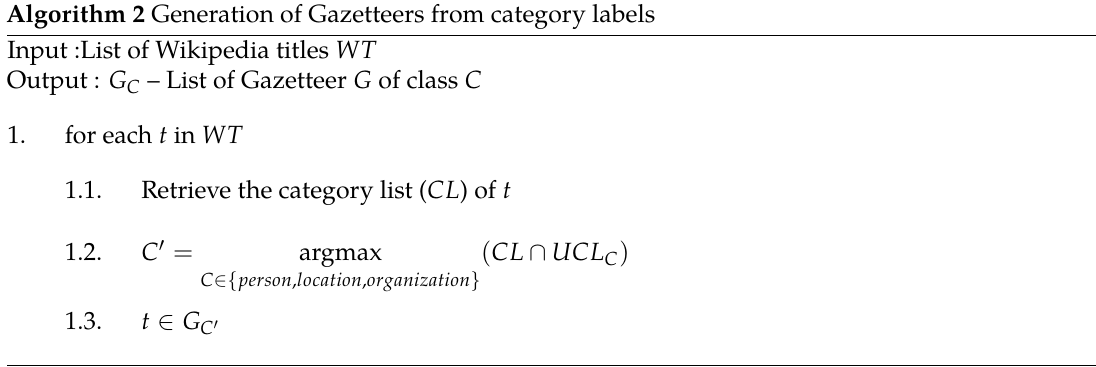
Algorithm 2 Generation of Gazetteers from category labels